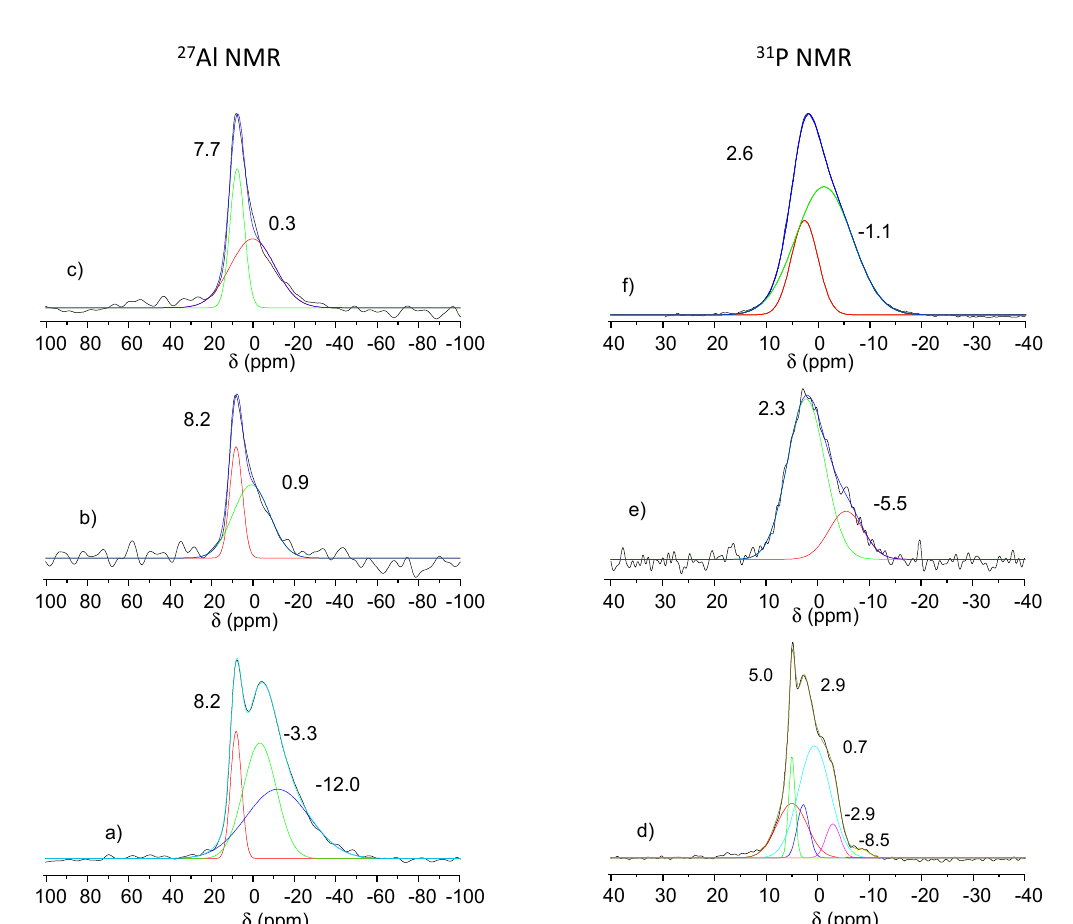
Figure 10. 27 Al SSNMR spectra of MgAl 200 /K 2 HPO 4 residues after 1 h ( a ); 7 days ( b ); 31 days ( c ); and 31 P SSNMR spectra of MgAl 200 /K 2 HPO 4 residues after 1 h ( d ); 7 days ( e ); 31 days ( f ).